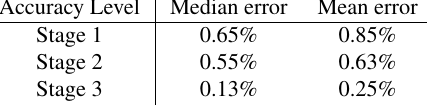
Figure 9. Path-based evaluation results